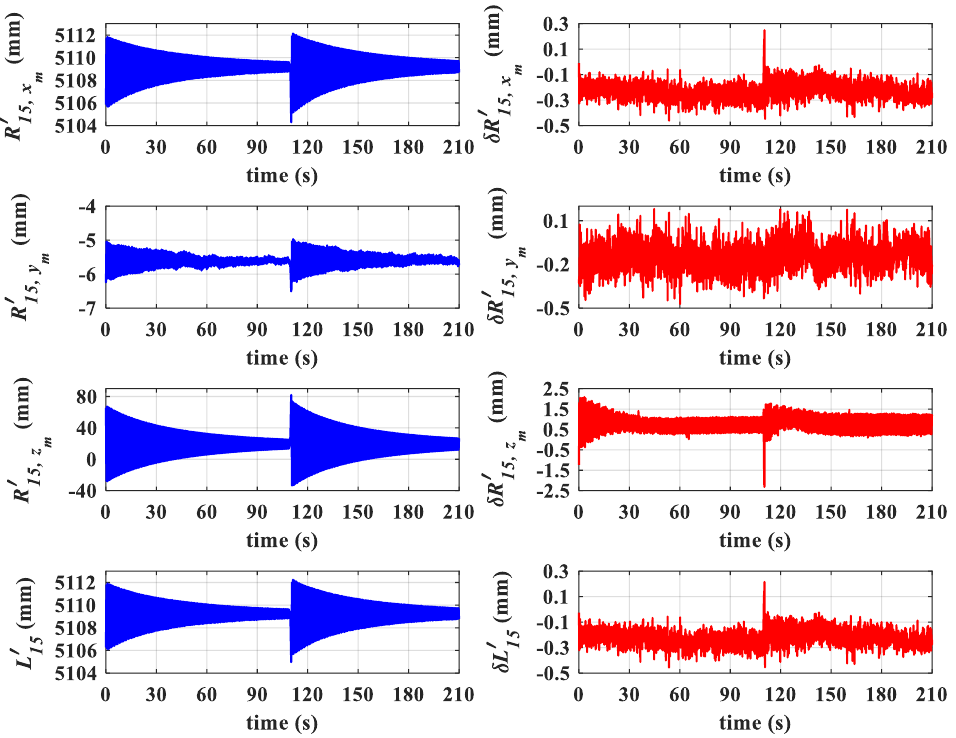
Figure 13. Measured values and errors of relative position and baseline length between antennas 1 and 5.